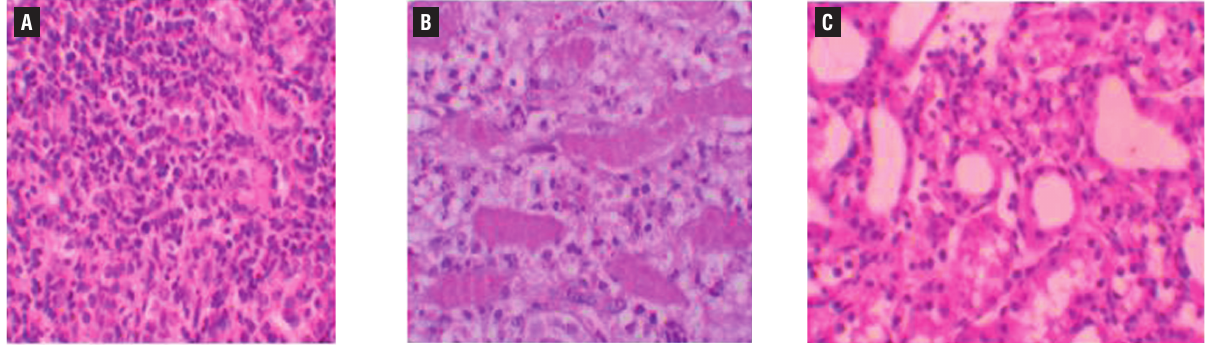
figure 2 - A) severe mononuklear leukocyte infiltration in the cortex of uuO group (hematoxylin & eosin x400) B) leukocyte infiltration was observed in the peritubular interstitium of the uuO (hematoxylin & eosin x400); c) leukocyte infiltration was reduced in the nahs-treated group (hematoxylin & eosin x400).